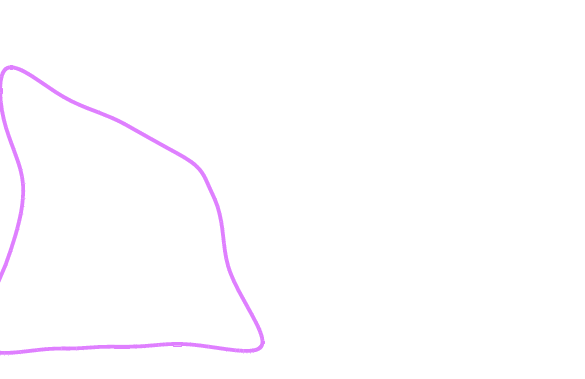
Figure 11. Boundary of deformation zone.